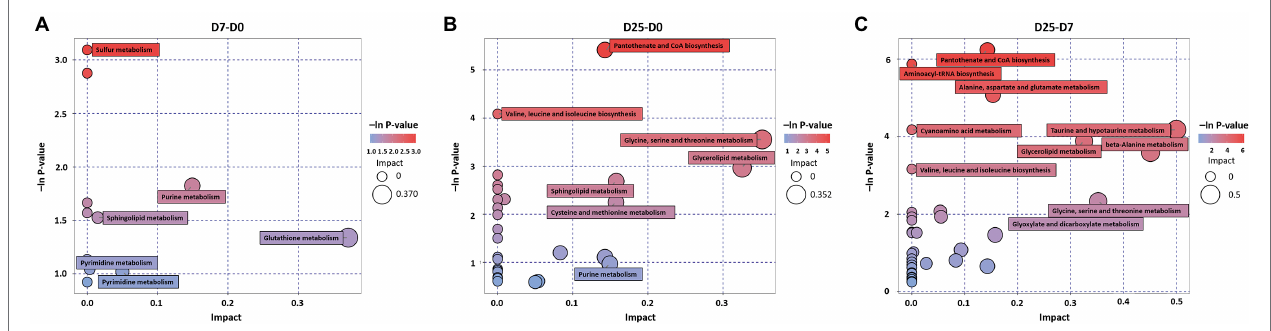
FIGURE 6 | Metabolome view map of significant metabolic pathways. (A–C) KEGG pathway enrichment analysis of differential metabolites between the comparison groups (D7 vs. D0, D25 vs. D0/D7). Significantly changed pathways are depicted based on analysis of the enrichment and topology. The bubble size and abscissa jointly indicate the magnitude of the impact factors of the pathway. D0, overfeeding for 0 days; D7, overfeeding for 7 days; D25, overfeeding for 25 days.